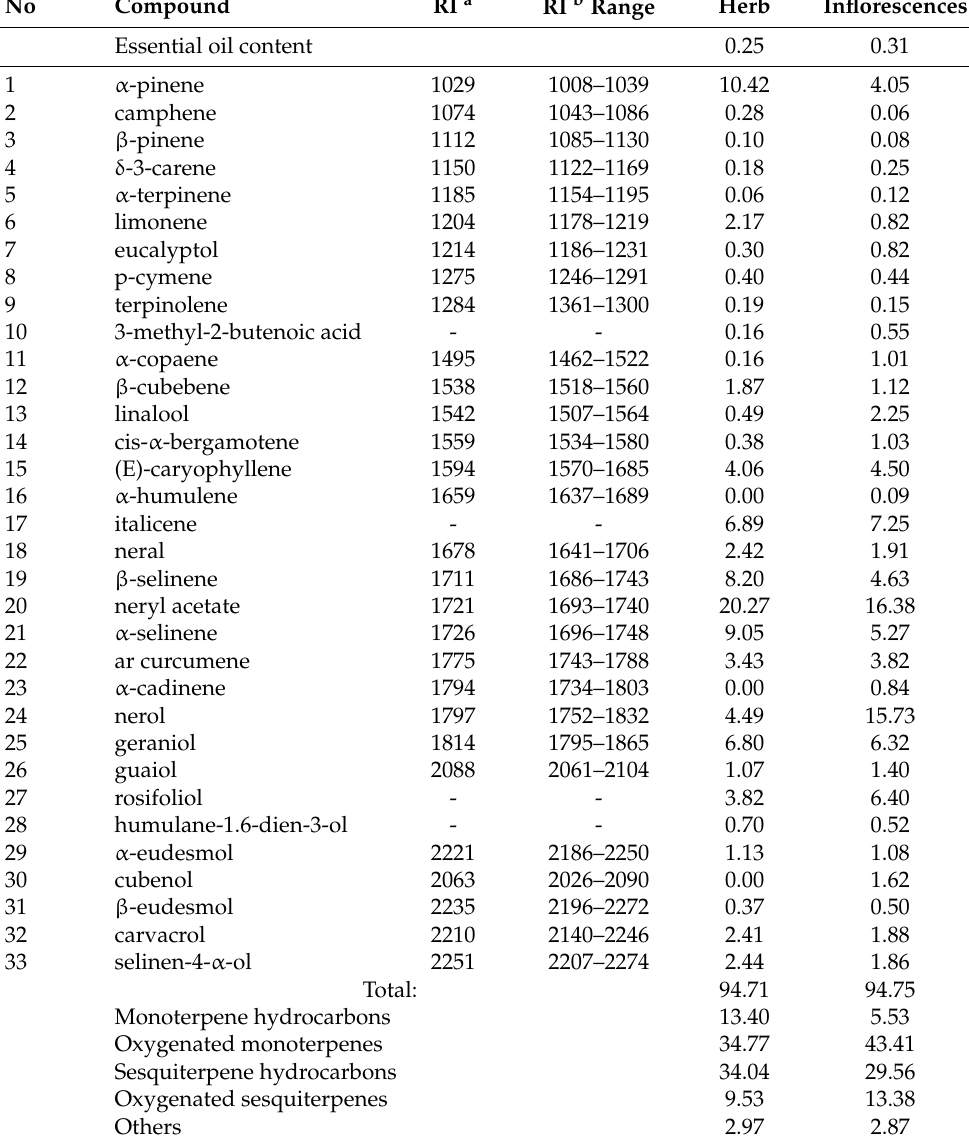
Table 2. The content (g × 100 g − 1 ) and chemical composition (% area) of essential